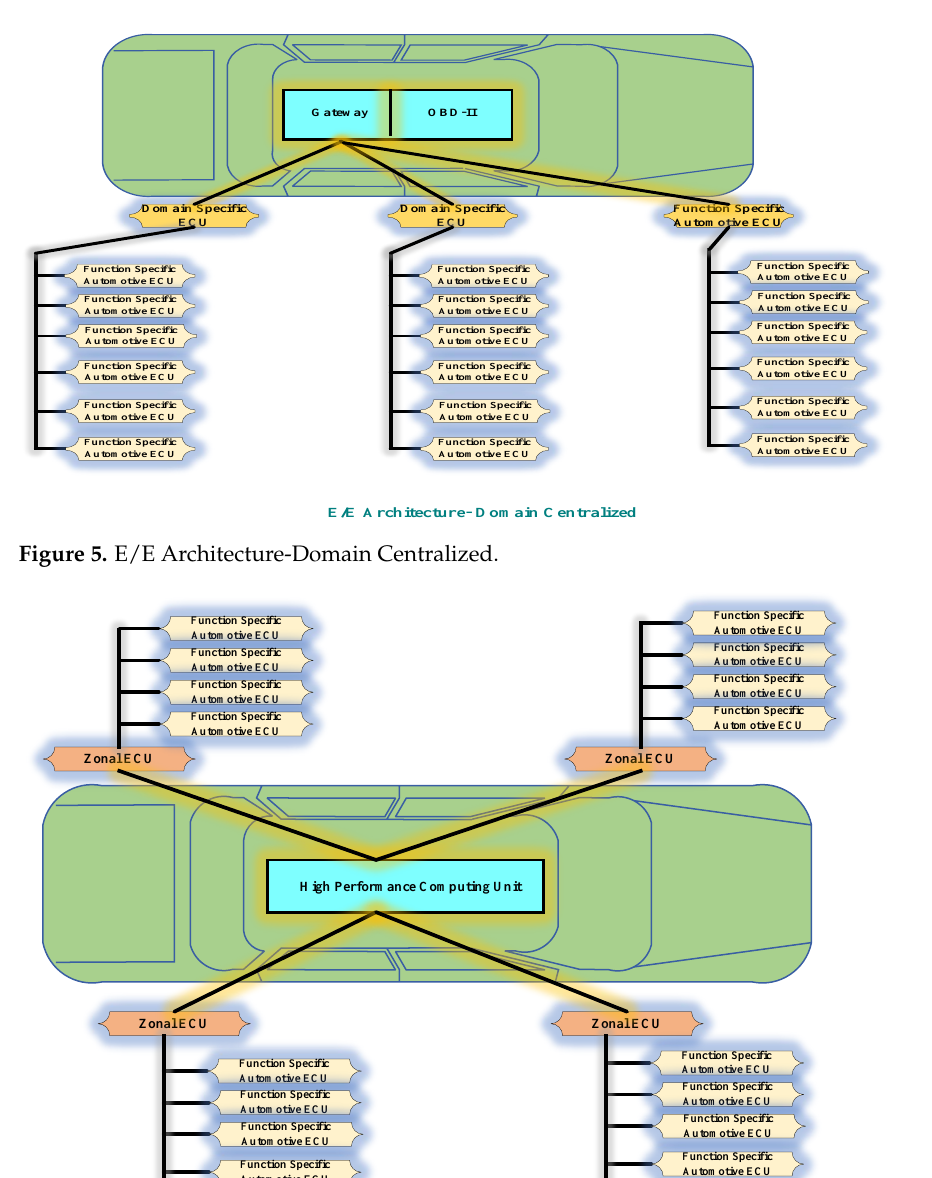
Figure 6. E/E Architecture-Zonal ECU and High-Performance Computing.